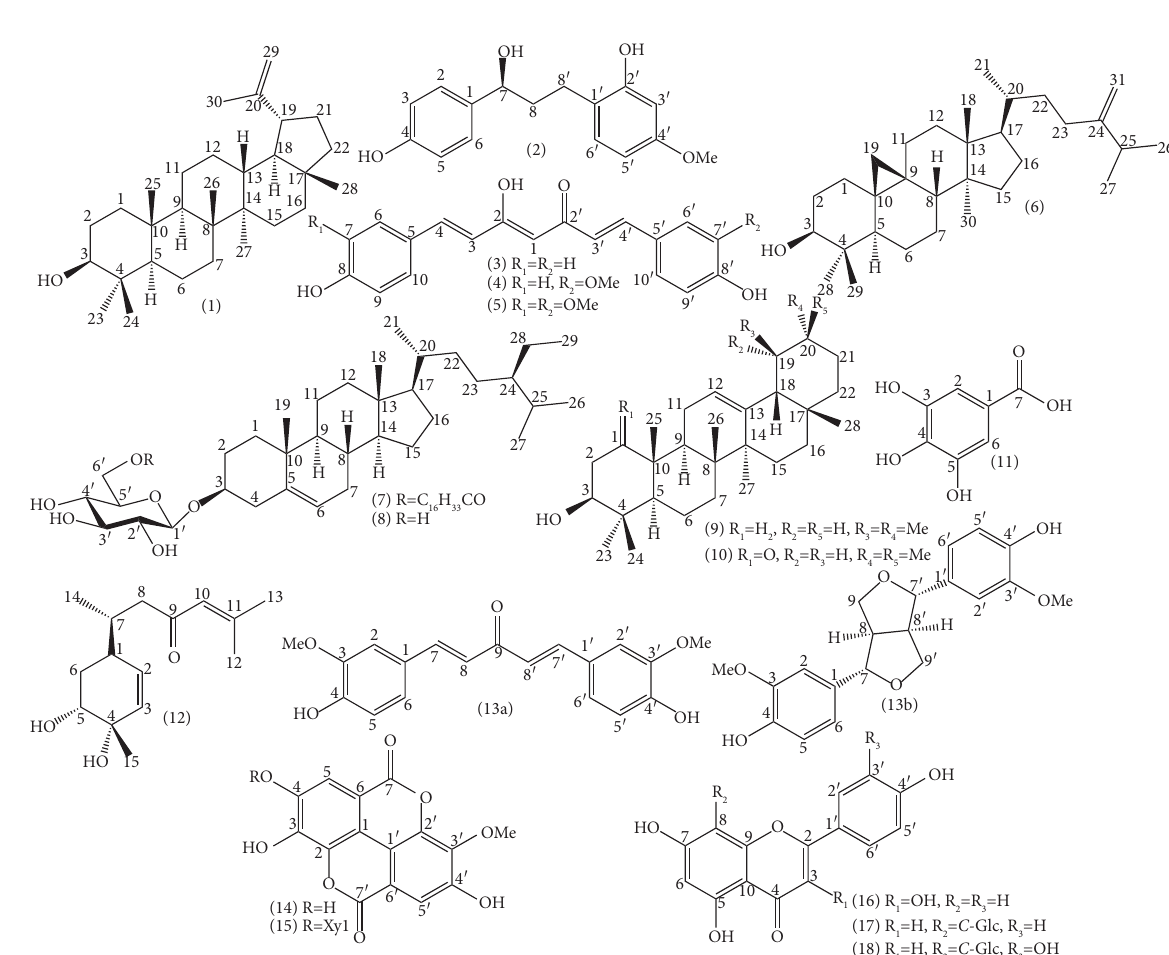
Figure 1: Chemical structures of isolated compounds ( 1 – 18 ) from M. tricolor